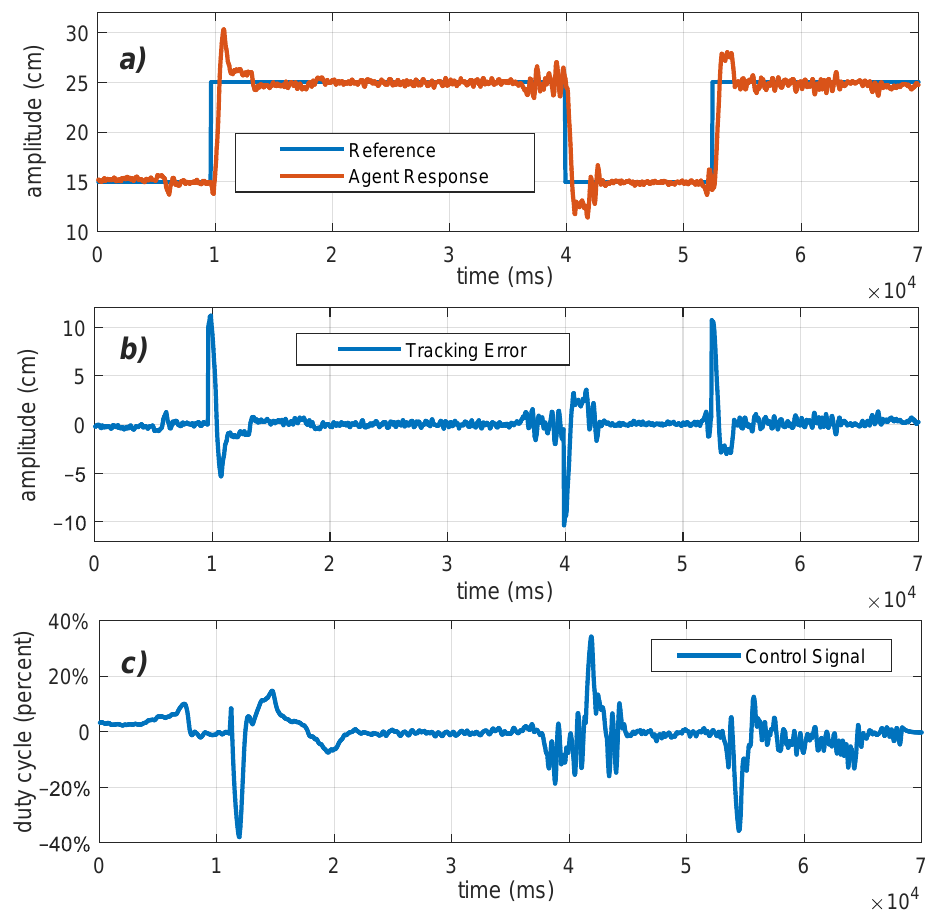
Figure 12. Experimental closed loop response of a single agent for step changes on the desired spacing to an obstacle using PI (the first 30 s) and PID control (the remaining time). ( a ) Distance reference and agent response. ( b ) Tracking error. ( c ) Control signal in terms of the duty cycle in percentage of the PWM signal (the sign defines the direction of